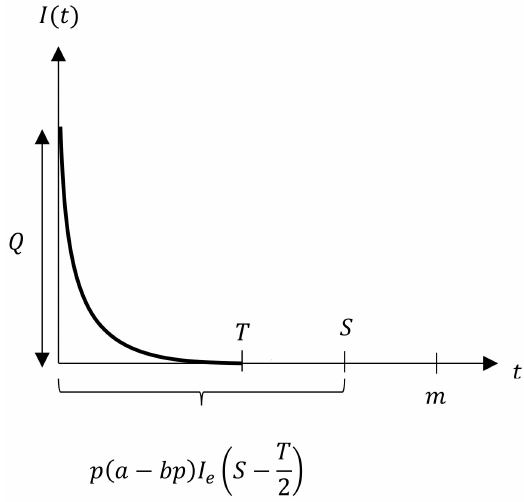
Figure 1. Inventory level for ( T ≤ S )